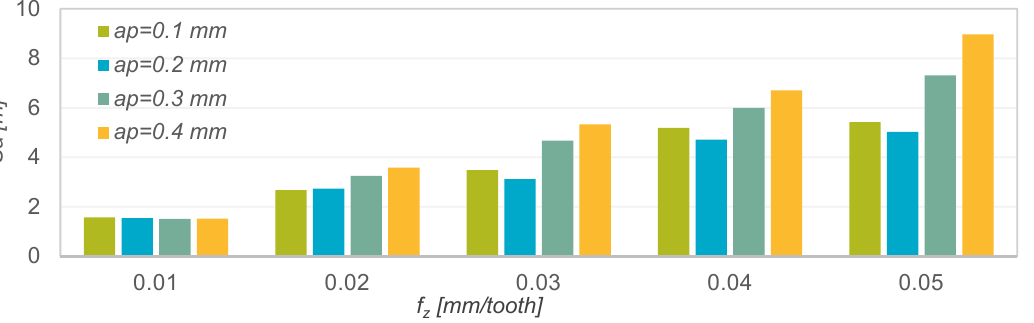
Figure 3. Results of measurements of the Sa roughness parameter as a function of feed per tooth f z and depth of cut a p .